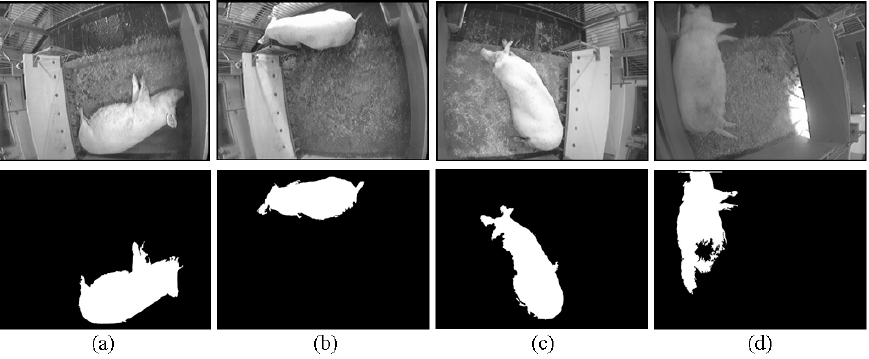
Figure 7. The general segmented results of the scale groups in the test data: ( a ) FS : under slow changes of illumination; ( b ) FS : under sudden changes of illumination; ( c ) PS ; ( d ) CNS